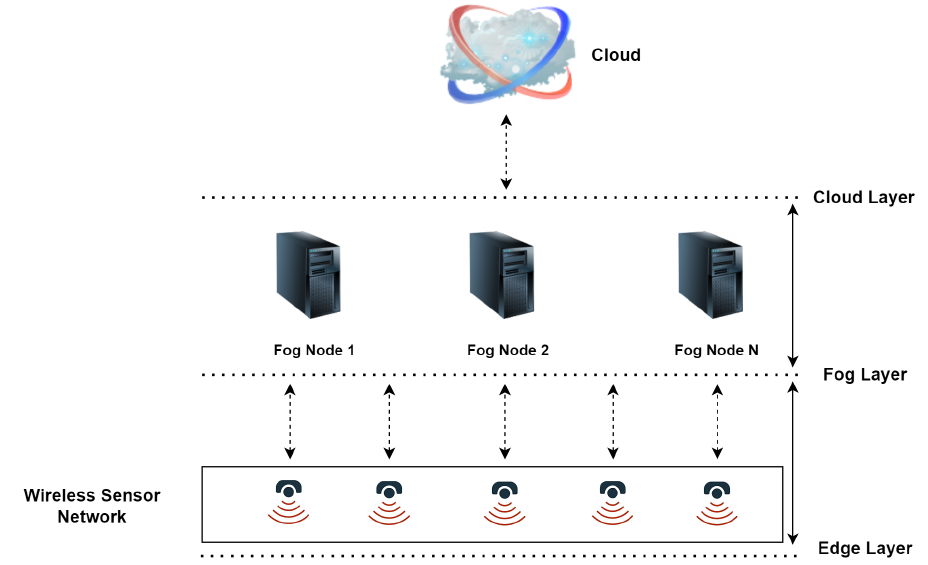
Figure 4. A schematic presentation of the general WSN